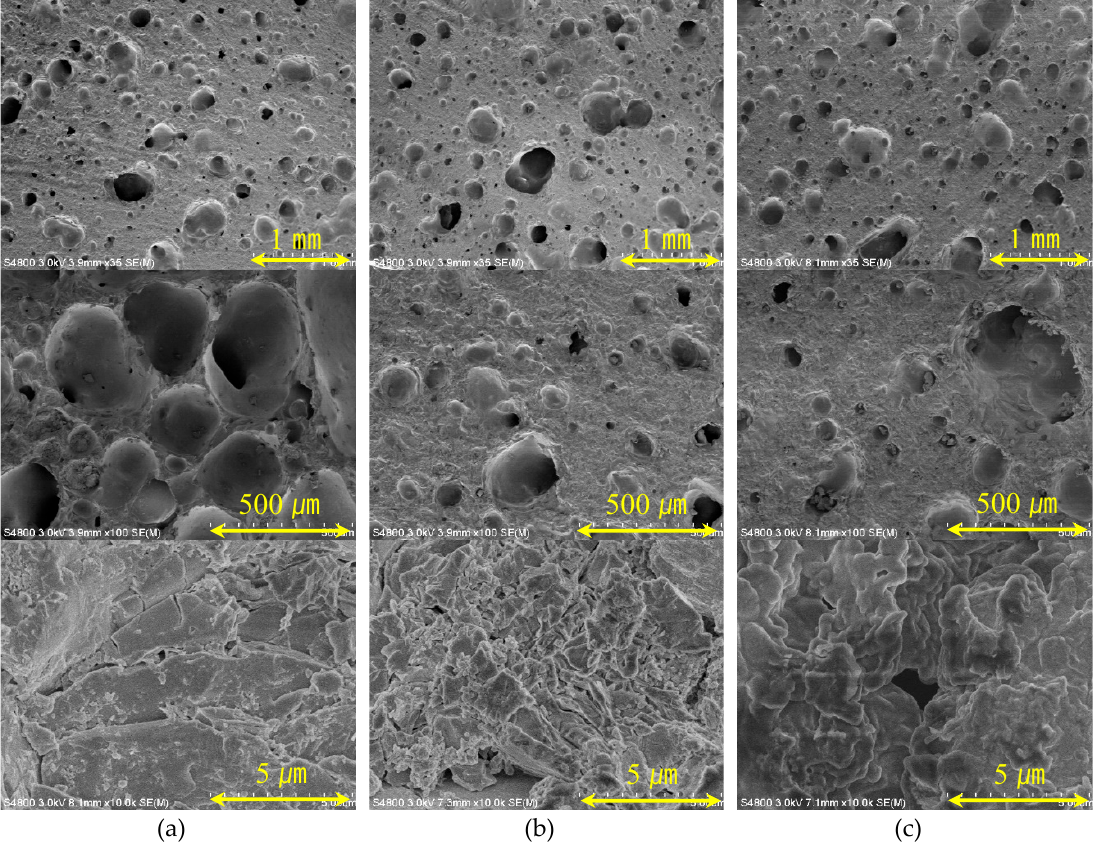
Figure 9. Scanning electron microscope (SEM) observation results of samples at firing input temperature 300 °C: ( a ) 210 min, ( b ) 240 min, and ( c ) 270 min.